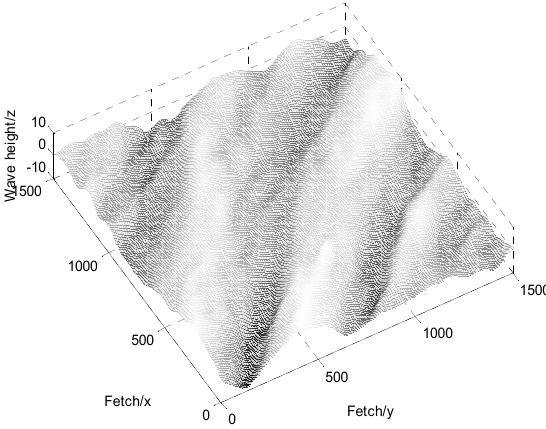
Figure 3. Simulation of 2-D sea surface by Monte Carlo method with wind speed 11 km / h, fetch 15 km and wind direction 320°.